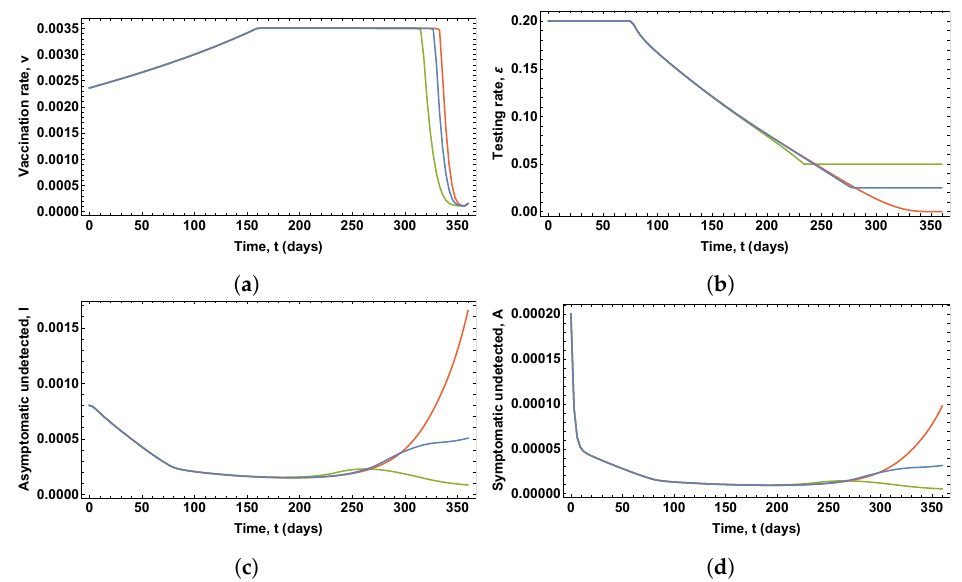
Figure 13. Optimal policies and proportions of people in each compartment obtained assuming κ L = 0 (red), κ L = 0.025 (blue), and κ L = 0.05 (green), with fixed parameters C 1 = 1, C 2 = 0.1, and C 3 = 0.1: ( a ) Optimal vaccination rates. ( b ) Optimal testing rates. ( c ) Asymptomatic undetected people. ( d ) Symptomatic undetected